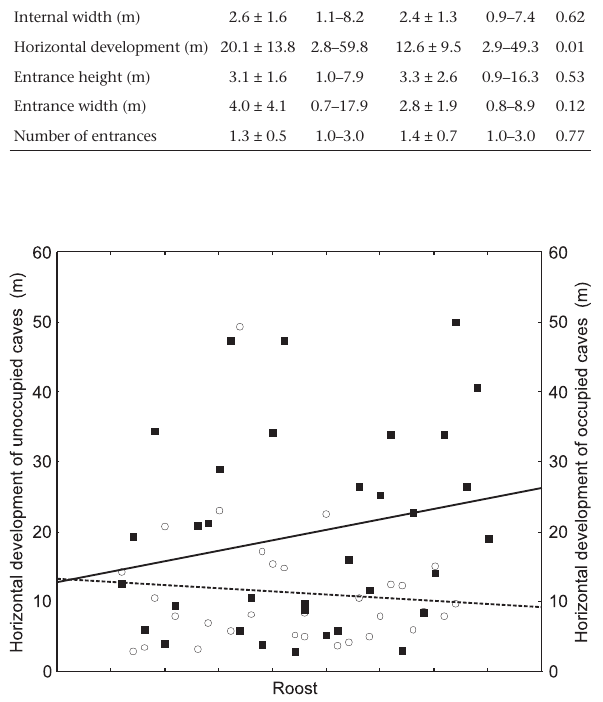
Figure 1. Maximum horizontal development of caves occupied (square filled) and unoccupied (open circles) as diurnal roosts by bats at the APA karst area of Lagoa Santa, Minas Gerais, Brazil, during